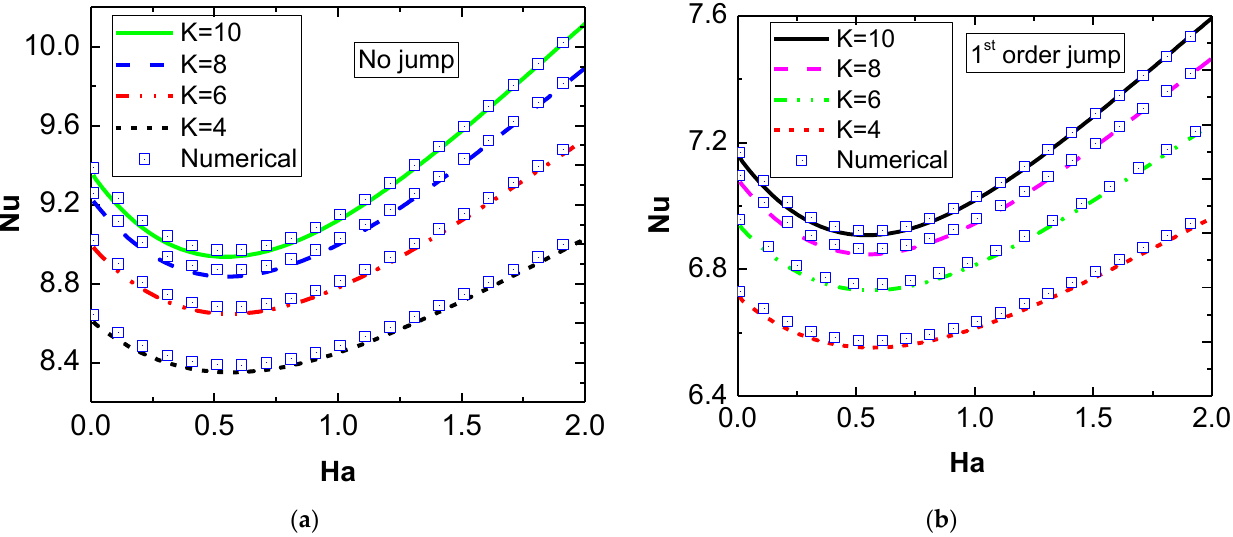
( ) Nu for variation with vary- . ( a ) No jump bound-